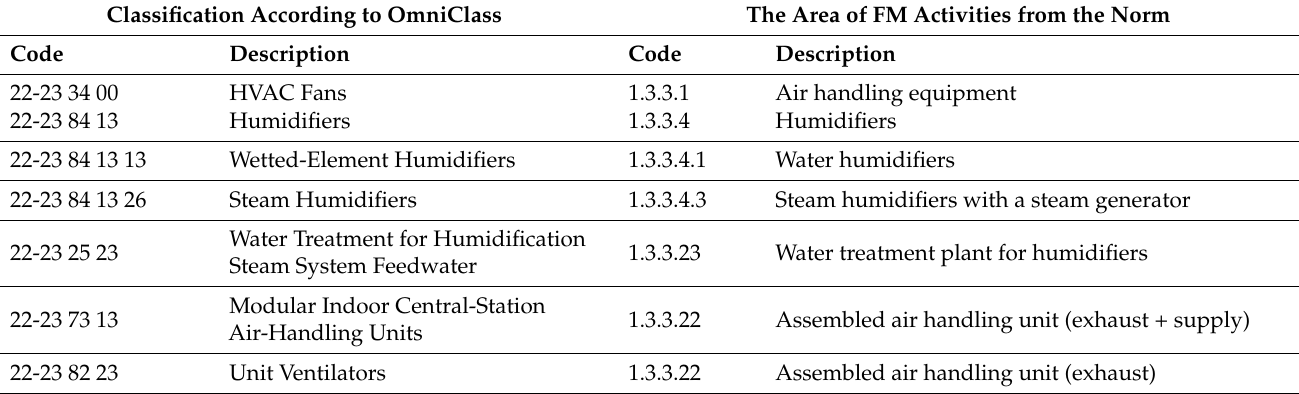
Table 4. Assigning a classification code to a preventive maintenance activity code. Source: